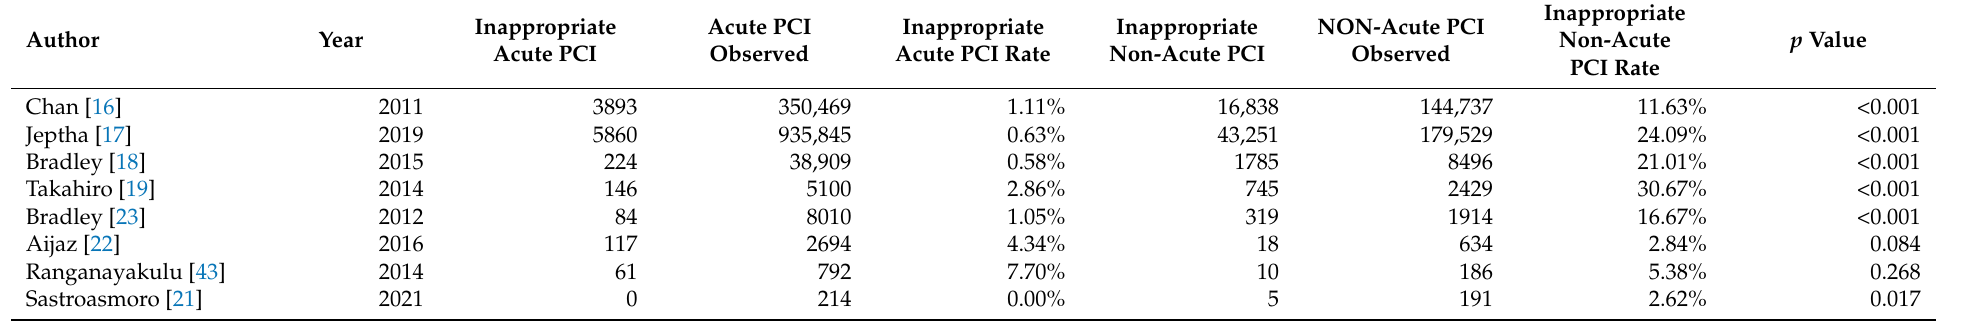
Table 2. The difference in the inappropriate PCI rate between acute and non-acute PCIs in studies presenting both urgent